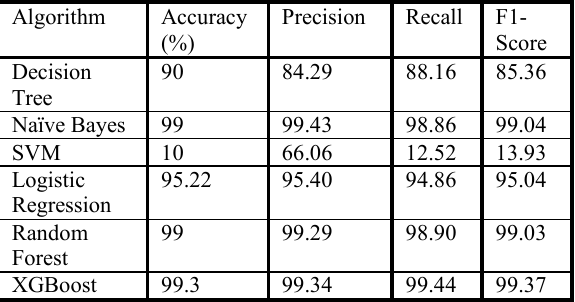
Figure 4.1 Comparing Accuracy of different Models The proposed system uses the XGBoost algorithm to predict the best top three crops for farmers based on soil and weather parameters as it has the highest accuracy. Table 4.1 Tabular Comparison of the Classifiers (in